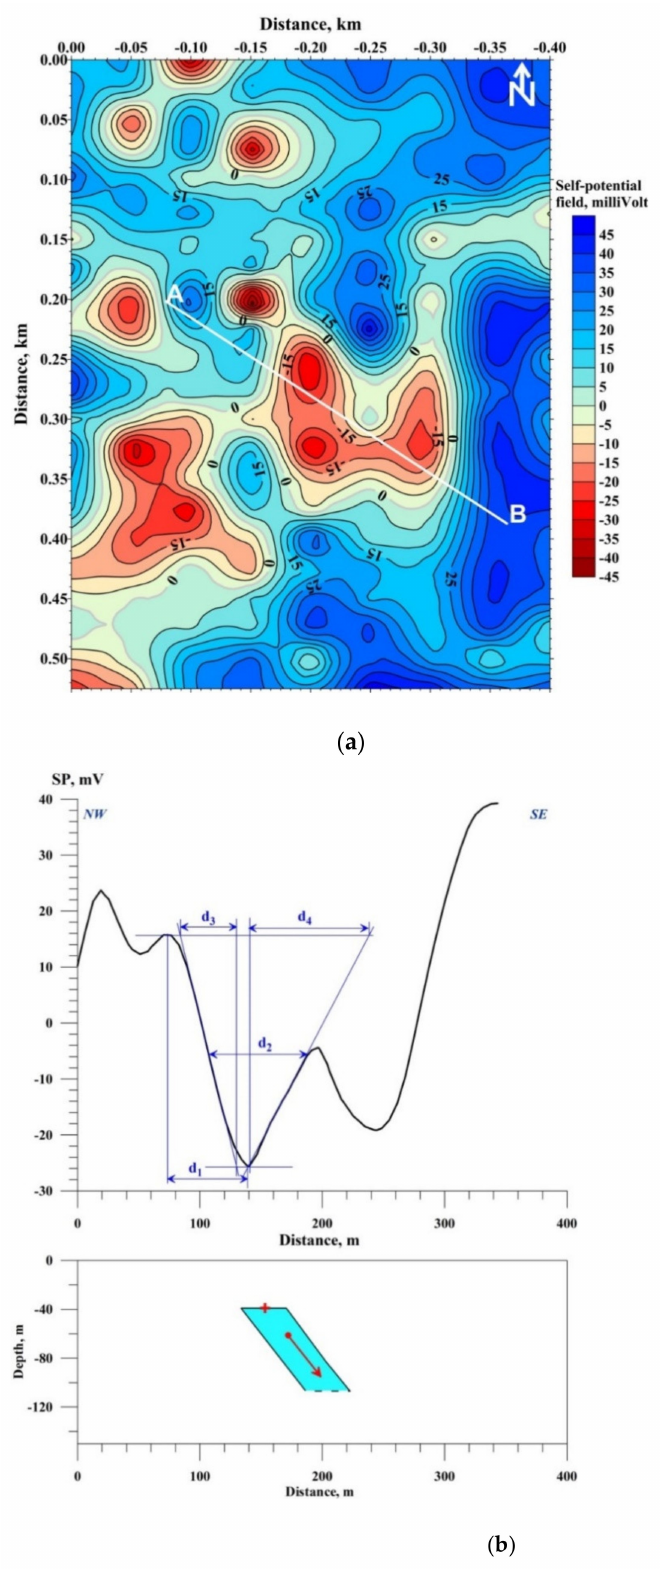
Figure 11. ( a ) SP map observed in the area of the western Makhtesh Ramon (northern Negev desert). Line A—B indicates position of the interpreting profile. ( b ) Interpretation of the SP anomaly along profile A—B, western Makhtesh Ramon (see Figure 11a) . The red cross indicates the position of the center of the upper edge of the anomalous body, and the red arrow indicates the orientation of the self-potential